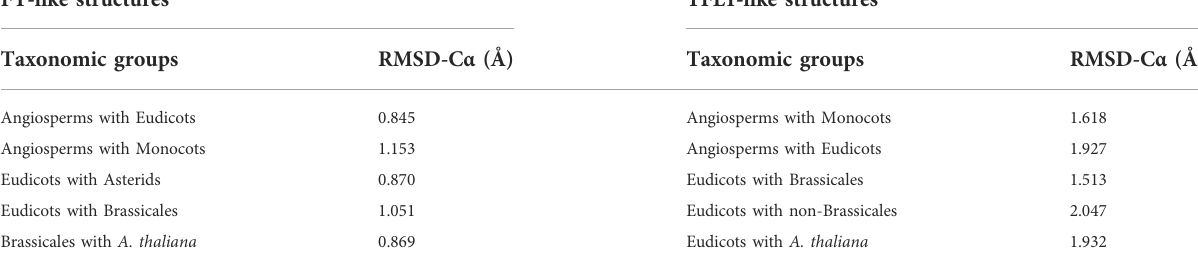
TABLE 1 Structural comparison between segments C of modeled ancestral structures of FT and TFL1. RMSD-C α values exhibited in angstroms. FT-like